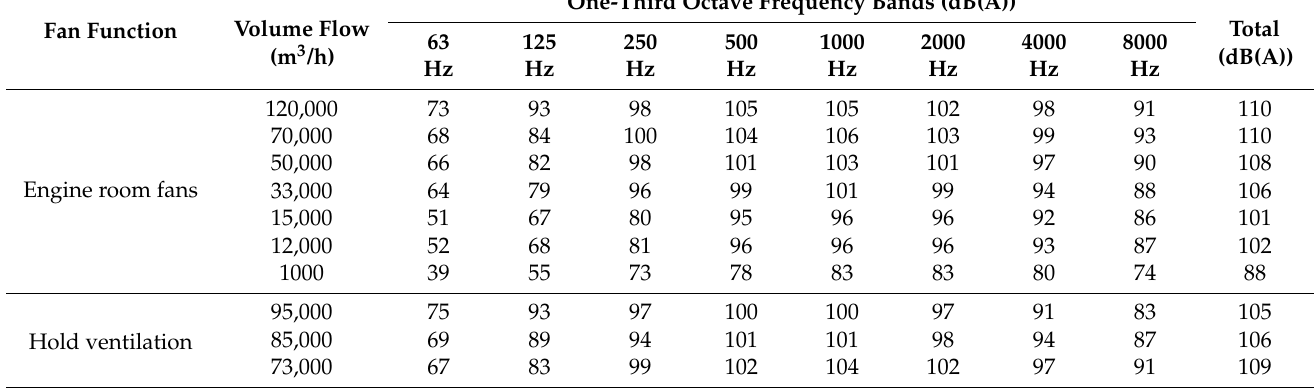
Table 5. One-third octave sound power level in dB(A) of different ventilation fans used in vessels without anti-noise measures